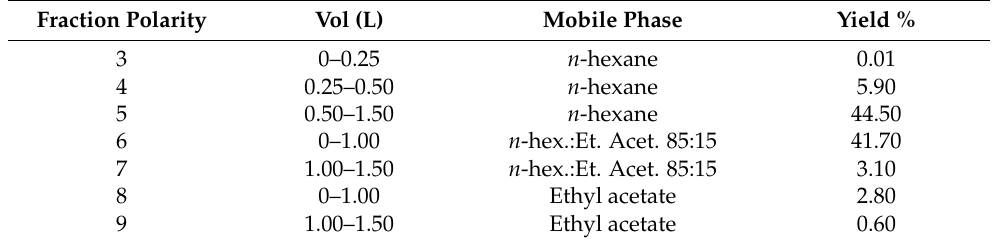
Table 1. Gravimetric data of bioethanol corn oil fractions obtained by SPE fractionation